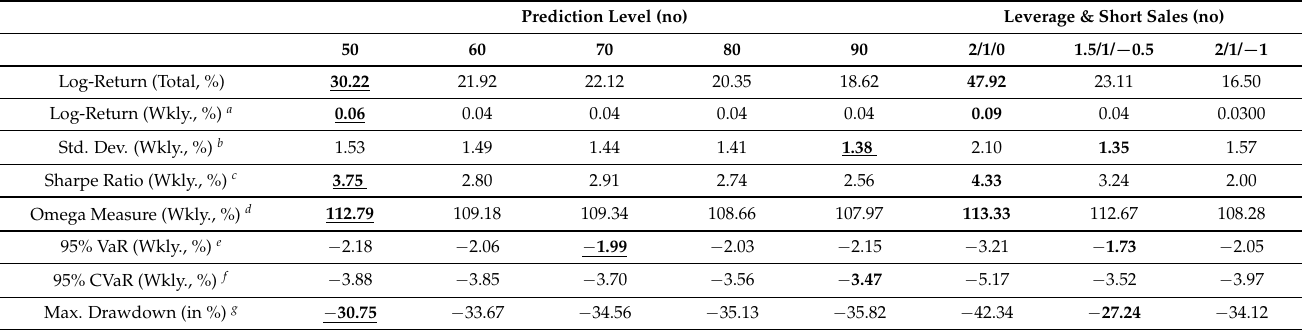
Table A12. Comparison of trading strategies for the out-of-sample period from 30 December 2005 until 5 February 2016. Prediction Level